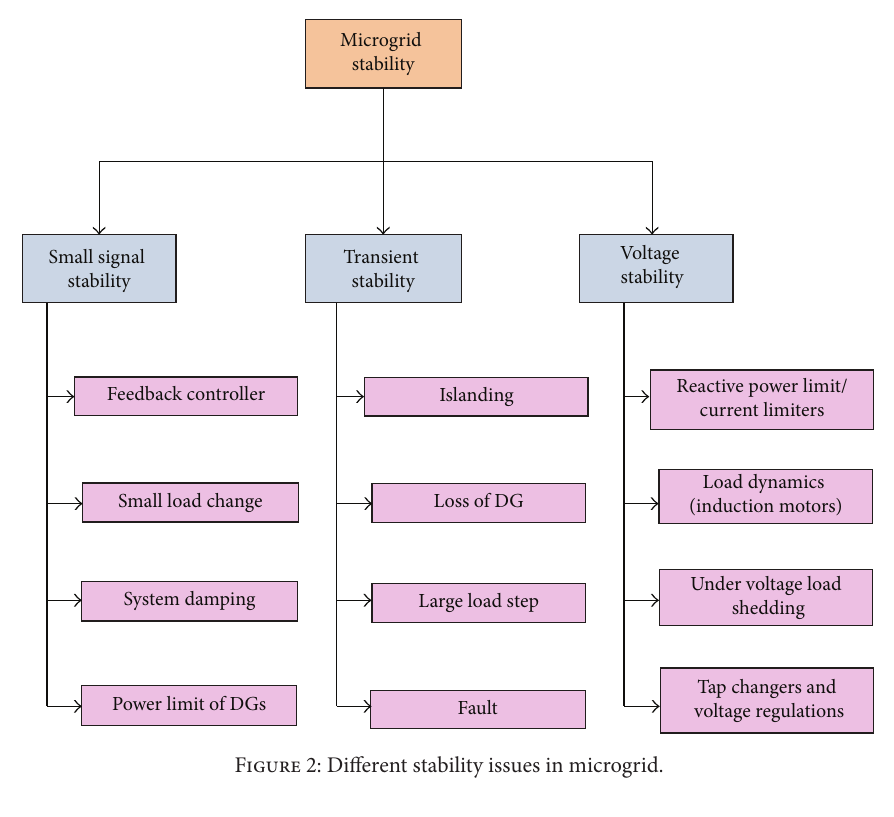
Figure 2: Different stability issues in microgrid.